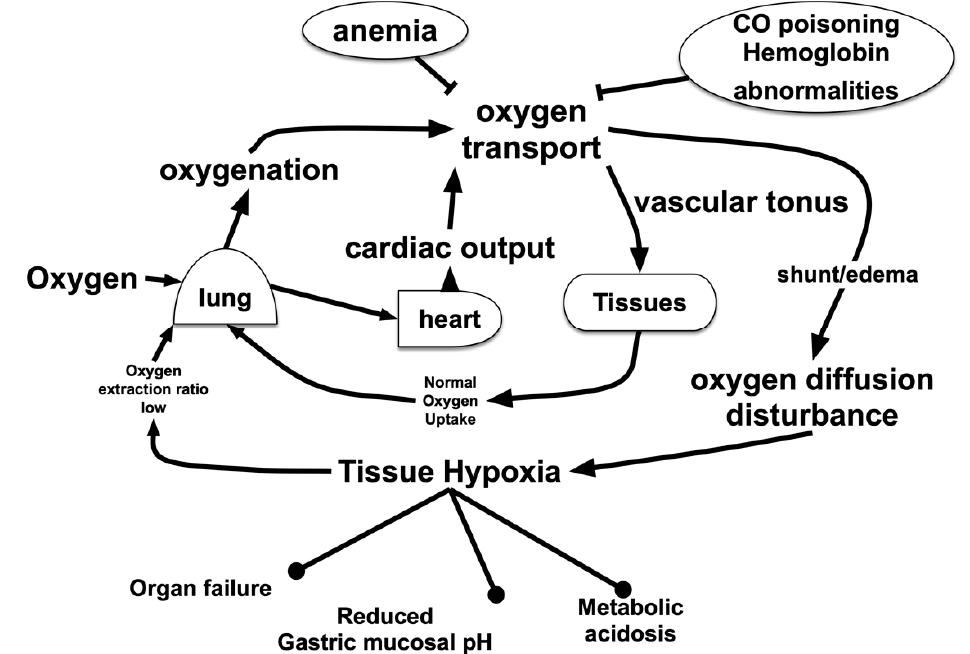
Figure 1. Oxygen (O 2 ) flow in the living body. O 2 is carried from the lungs to peripheral organs and tissues by red blood cells through blood vessels. Impaired oxygenation due to lung injury, disorders in transport due to anemia or blood clots and/or disturbance of transition from blood vessels to cells due to interstitial edema result in tissue hypoxia. In addition, O 2 -related metabolic disturbances due to suppression of O 2 utilization, such as drug-induced mitochondrial suppression, might have an effect on the living body, which is equivalent to that of